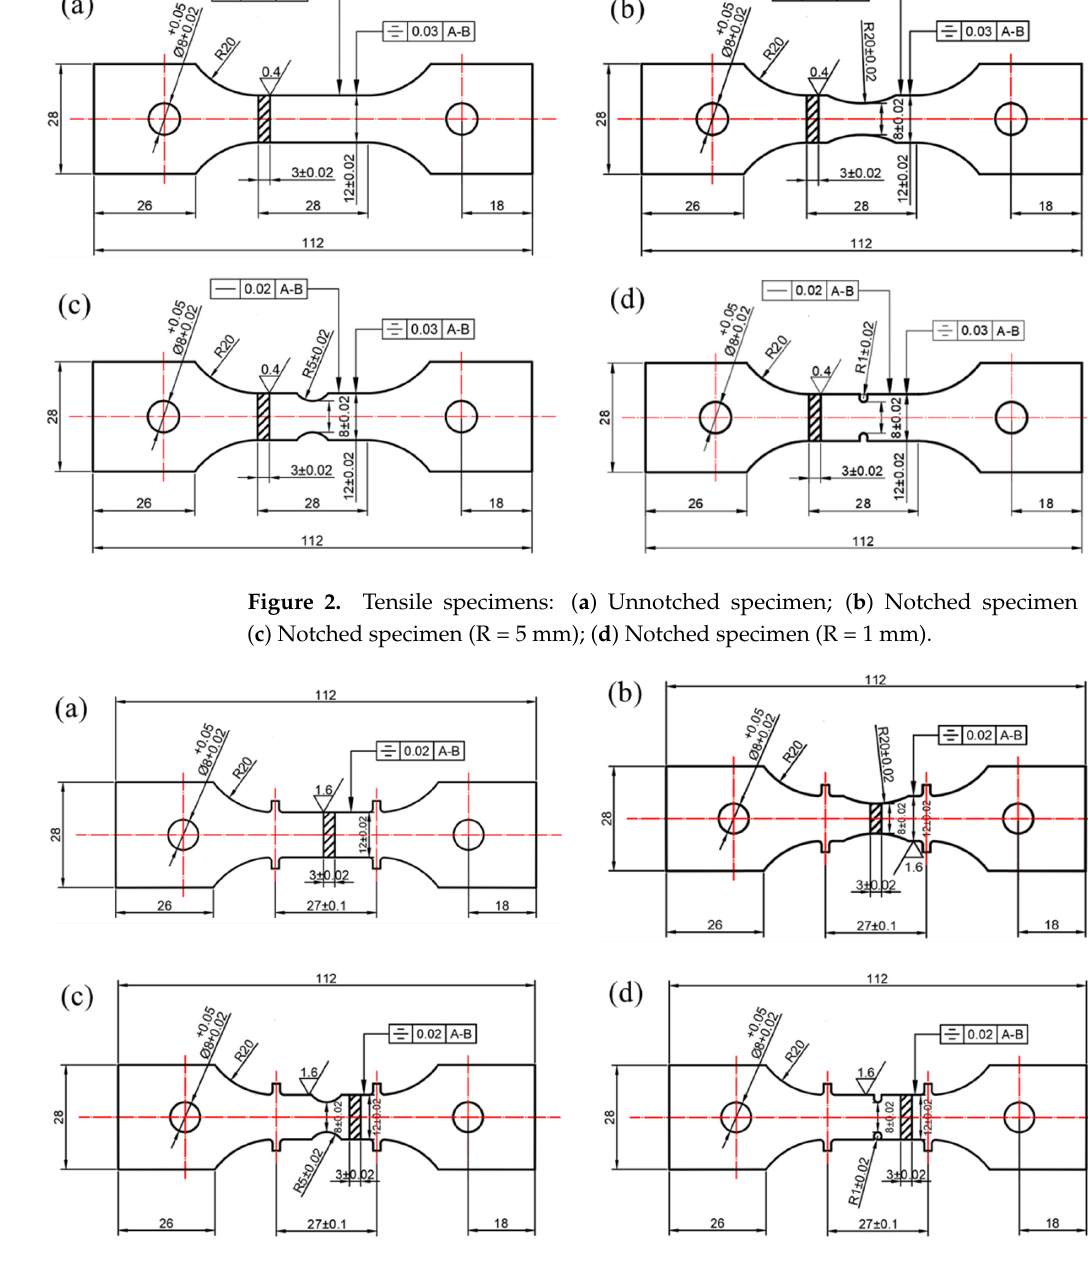
Figure 3. Creep specimens: ( a ) Unnotched specimen; ( b ) Notched specimen (R = 20 mm); ( c ) Notched specimen (R = 5 mm); ( d ) Notched specimen (R = 1 mm).